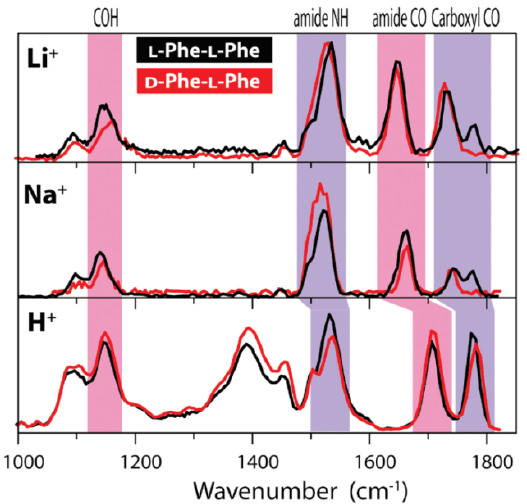
Figure 10. Experimental IRMPD spectra of ( top , middle ) alkali metal ion complexes with the LL and DL stereoisomers of the dipeptide PhePhe and ( bottom ) the protonated LL and DL dipeptides. The splitting of the carboxyl CO stretching peak into two components in the LL complexes (black traces), which is evident for Na + and Li + , reflects the nearly equal stabilities of two spectrally distinct conformers. For the DL dipeptide (red traces), only one of the conformeric motifs is formed with Na + and Li + , as indicated by the complete absence of one of the carboxyl CO stretching bands [58]. Reprinted with permission from ACS.